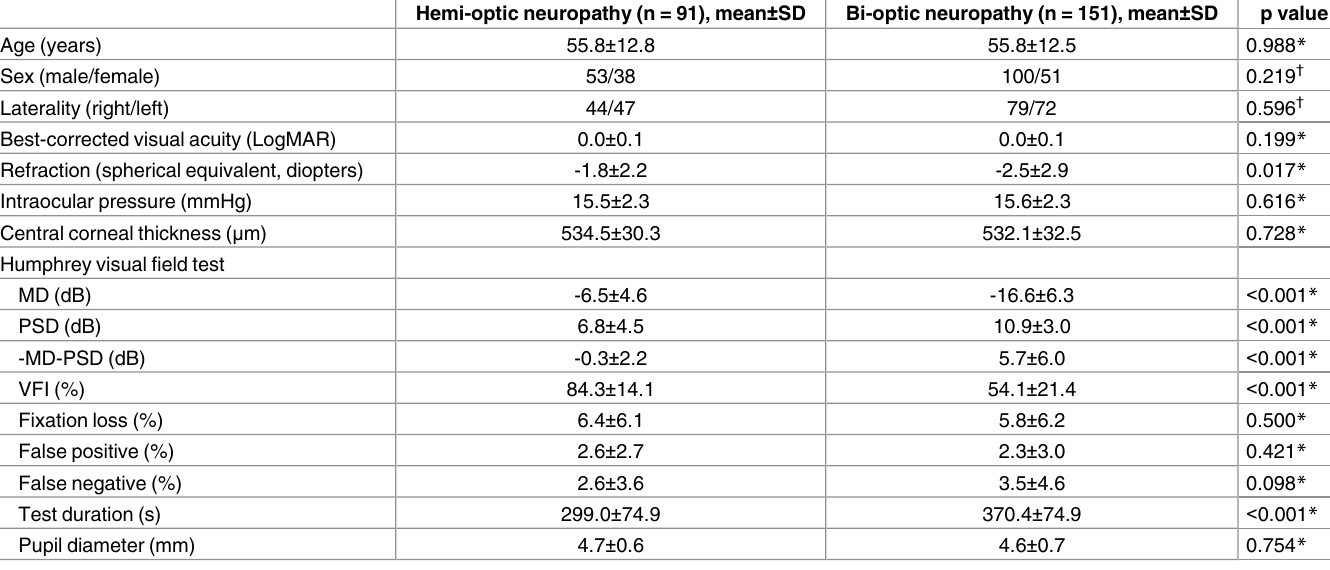
Table 1. Demographics of patients with hemi-optic or bi-optic neuropathy. Hemi-optic neuropathy (n = 91), mean ± SD Bi-optic neuropathy (n = 151), mean ±